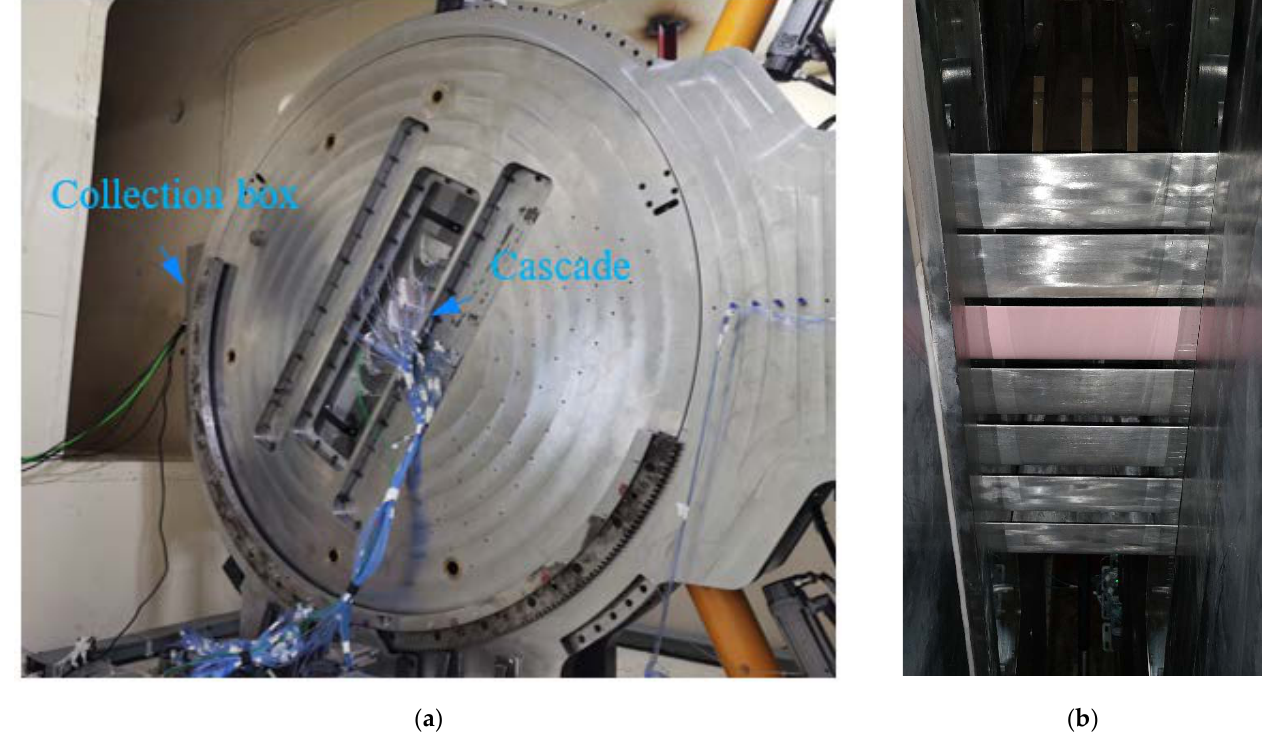
Figure 2. Diagram of wind tunnel test device. ( a ) Experimental chamber; ( b ) cascade (backward sight).